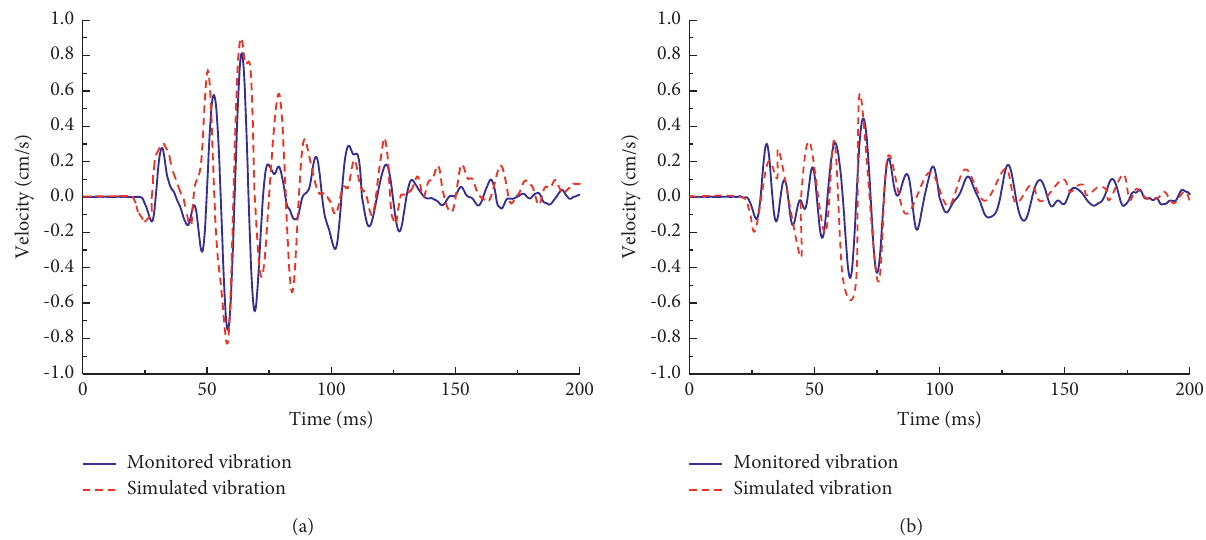
Figure 15: Comparisons of the vertical velocity histories between simulated results and monitoring data at (a) No. 6 observation point on the tunnel surface and (b) No. 9 observation point on the tunnel entrance slope